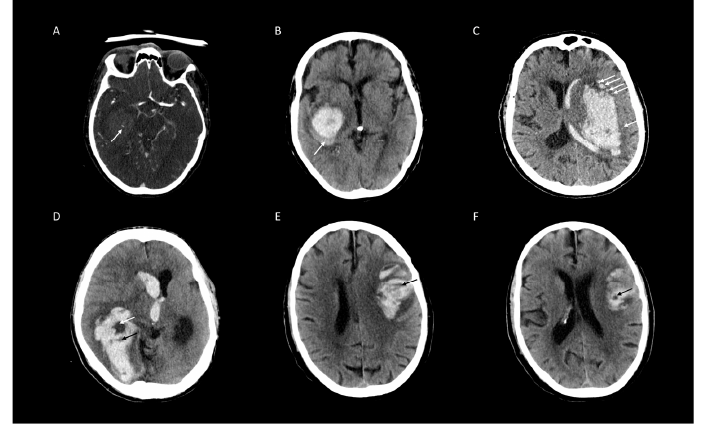
Figure 3. Representative examples of agreed ratings of four non-contrast computed tomographic (NCCT) markers and Spot Sign (SS) on CT-angiography (CTA) for intracerebral hemorrhage expansion. ( A ) SS on CTA (white arrow). ( B ) Blend Sign (white arrow). ( C ) Island sign (all white arrows). ( D ) Black Hole Sign (white arrow), Hypodensities (black arrow). ( E ) Hypodensities (black arrow). ( F ) Black Hole Sign (white arrow).